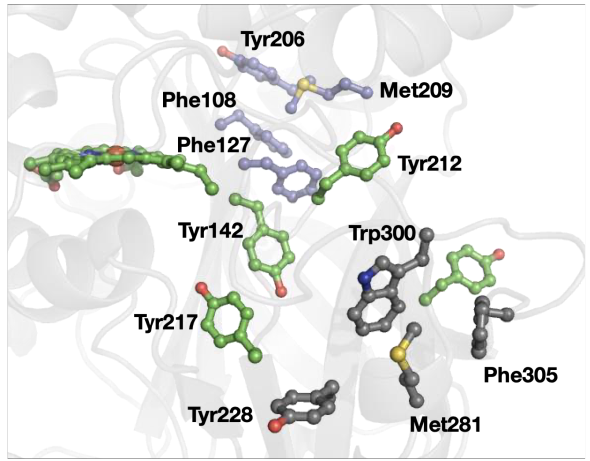
Figure 6. Structure of yeast catalase (PDB ID 1A4E [53]). The 3-bridge clusters are highlighted in gray and lavender, and the heme and other tyrosine residues are in green. Red corresponds to oxygen, yellow to sulfur, and blue to nitrogen. The image was generated using PyMOL.